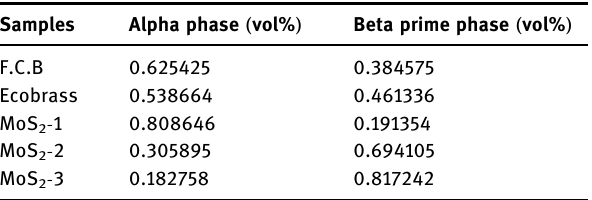
Table 4: Volume fraction of alpha and beta prime phases for all samples